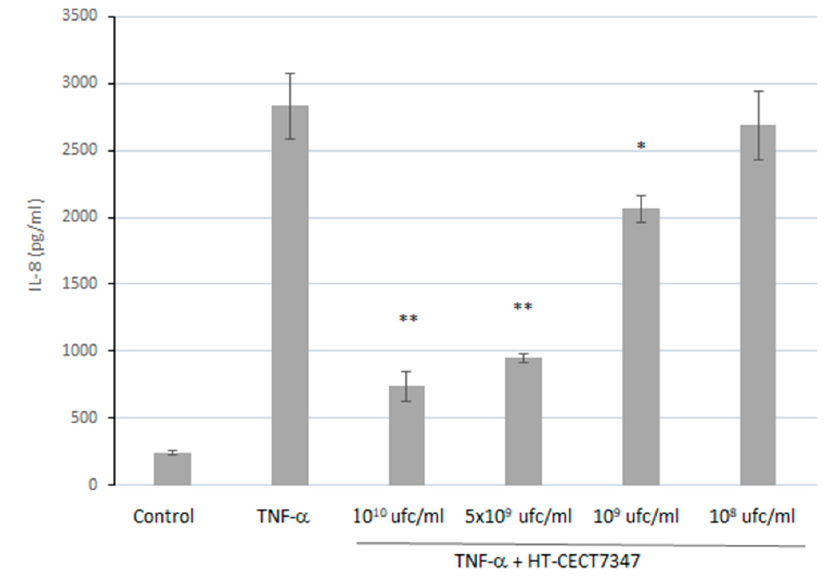
Figure 4. Quantification of IL-8 secretion by HT-29 cells incubated with HT-CECT-7347 and stimu- lated with TNF- α . Data are given as means and standard deviation ( n = 2). *, ** indicates significantly lower than TNF- α control ( p < 0.05 and p < 0.01, respectively).